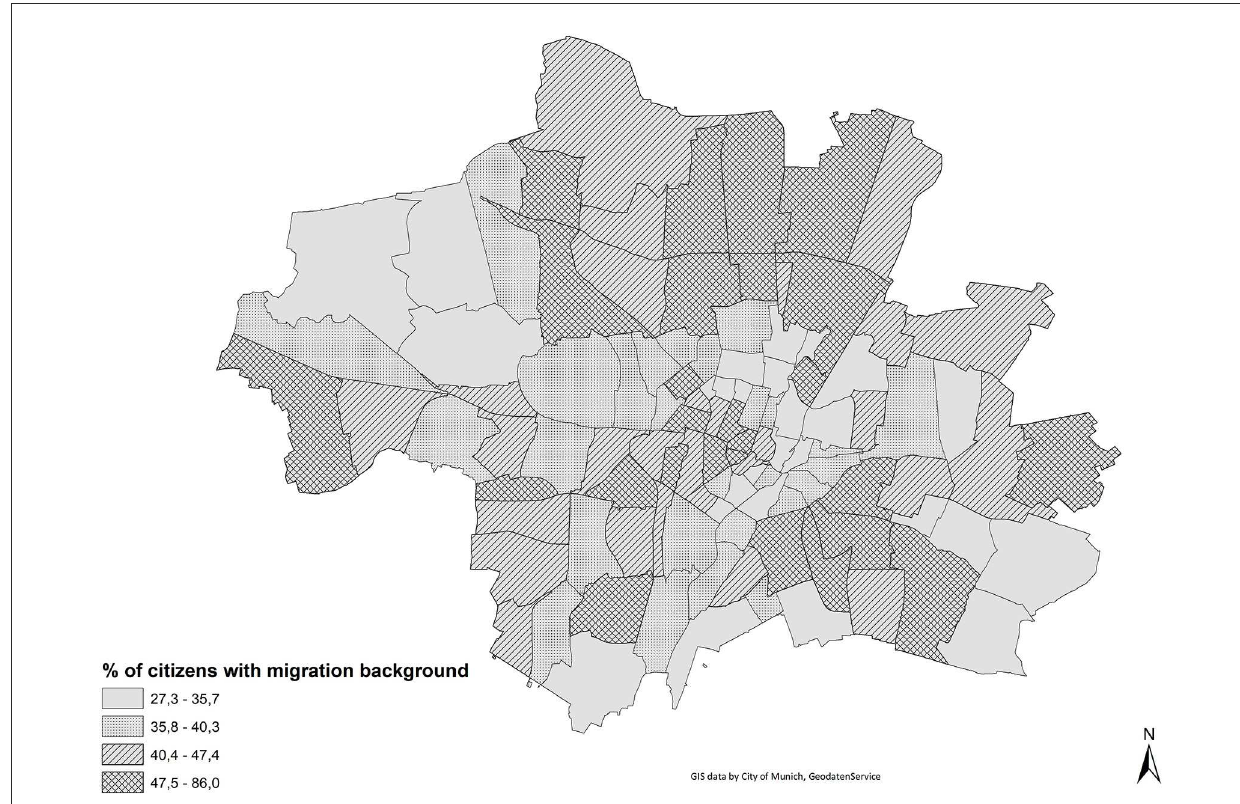
FIGURE3 Proportion of migrants, grouped by quartiles.